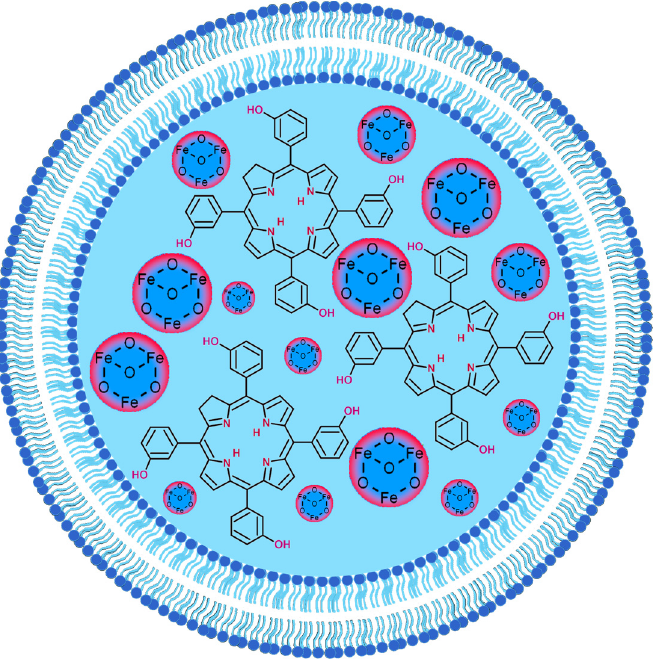
Figure 3. The schematic structure of the liposome–cargo magnetic particles with Foscan [16].